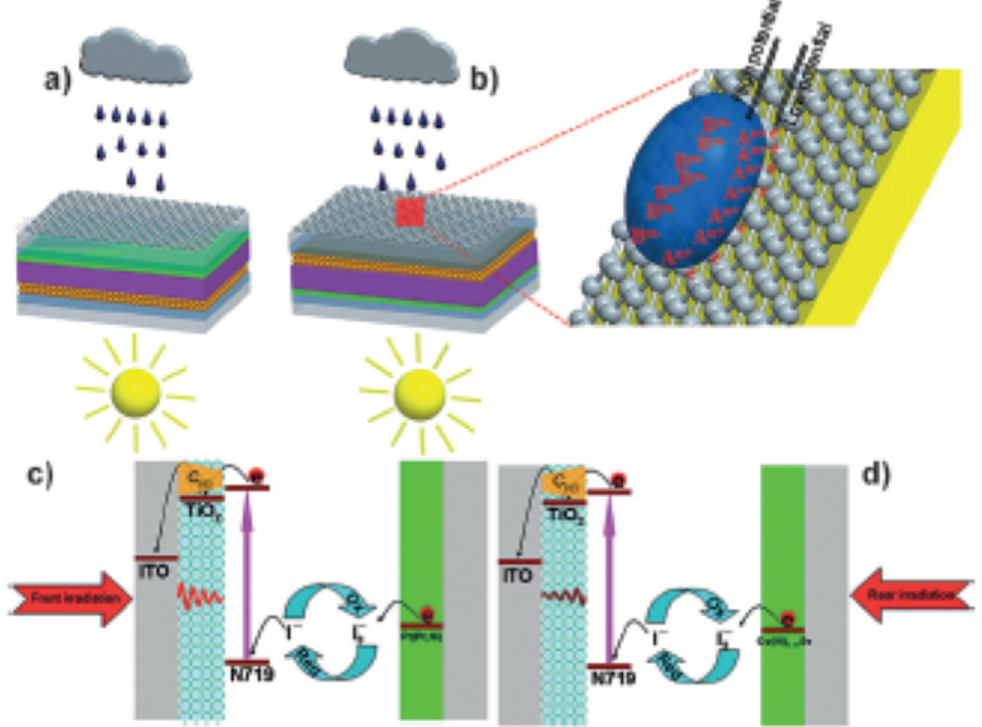
Figure 11. The bi-triggered flexible solar cell for recording photovoltaic performance under ( a ) front or ( b ) rear irradiation and measuring current and voltage signals by dropping raindrops (including A n+ and B m − ions) onto rGO film. ( c , d ) The operational principle of the flexible solar cell under sunlight. The rGO film is deposited on the PET side and solar cell is assembled on the ITO side. The two electrodes for measuring current and voltage signals in the presence of raindrops are coated with silver paint and subsequently protected with ethylene vinyl acetate copolymer. The droplets are injected by a medical syringe by controlling injection velocity. Reproduced with permission from [5] © 2021 WILEY-VCH Verlag GmbH & Co. KGaA, Weinheim, Germany.